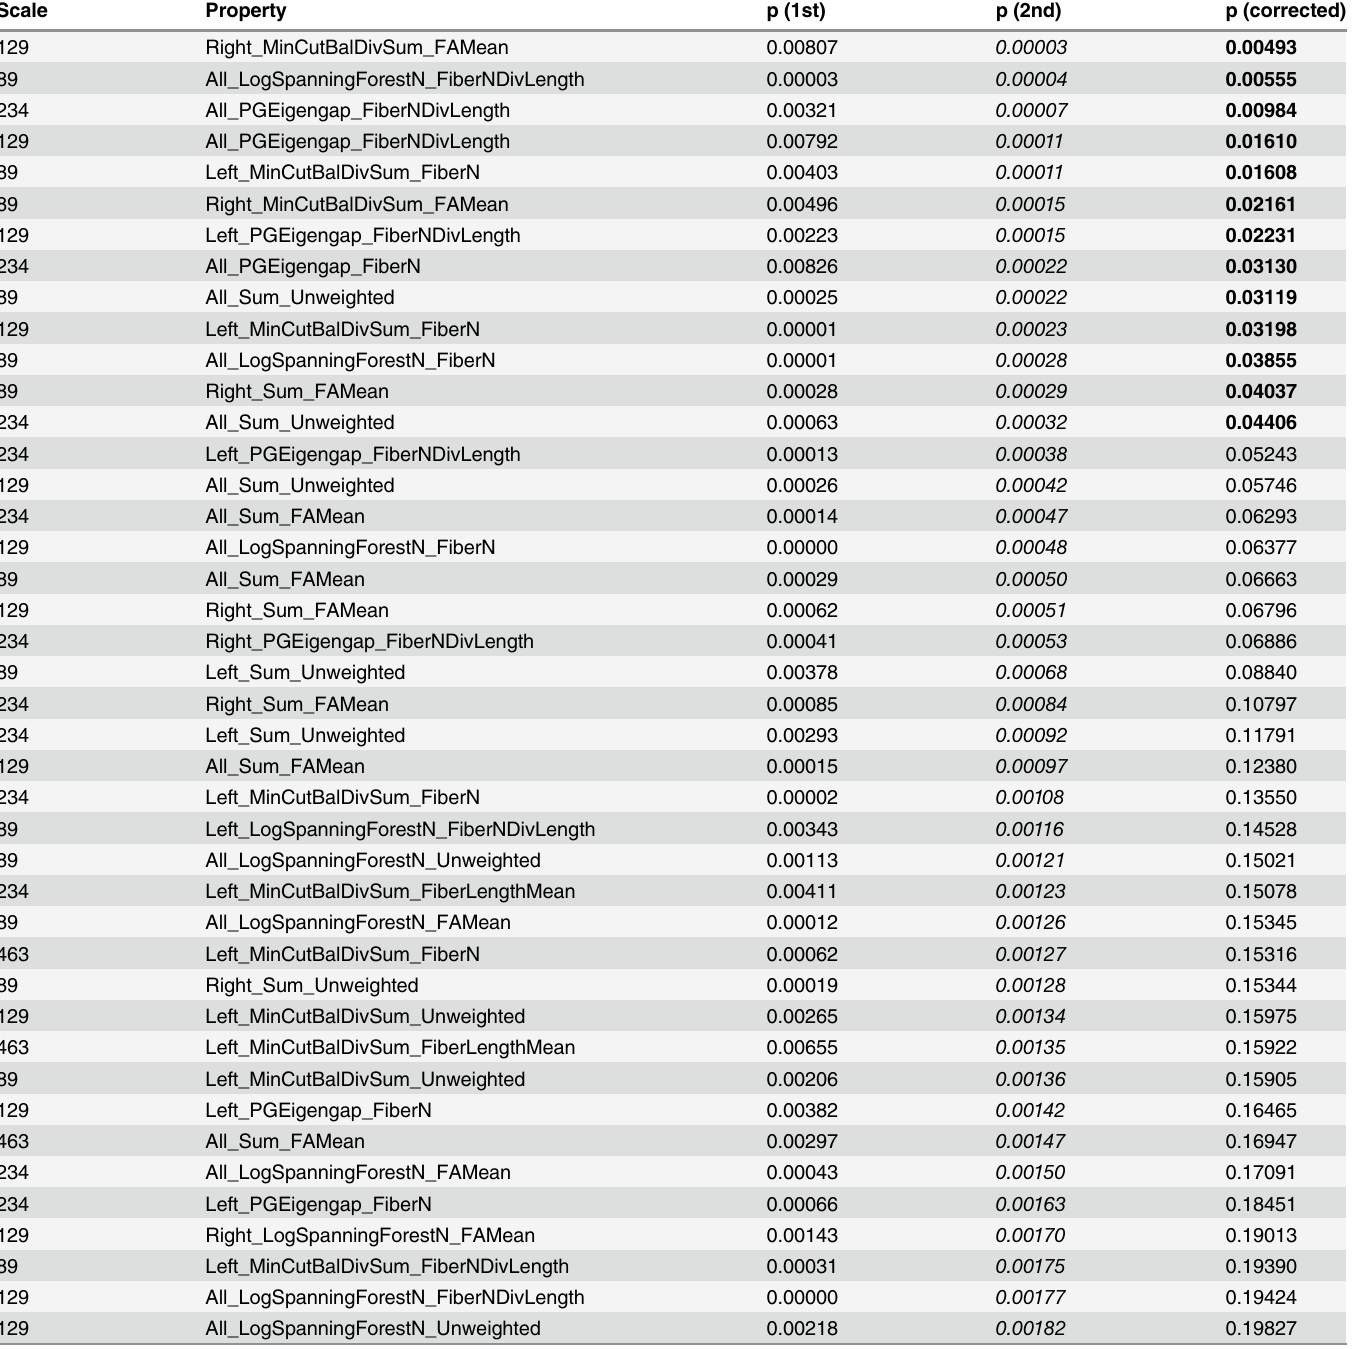
Table 1. The results and the statistical analysis of the graph-theoretical evaluation of the sex differences in the 96 diffusion MRI images. The first column gives the resolutions in each hemisphere; the numbers of nodes in the whole graph are 83, 129, 234, 463 and 1015. The second column describes the graph parameter computed: its syntactics is as follows: each parameter-name contains two separating “ _ ” symbols that define three parts of the parame- ter-name. The first part describe the hemisphere or the whole connectome with the words Left, Right or All. The second part describes the parameter com- puted, and the third part the weight function used (their definitions are given in section “ Materials and methods ” ). The third column contains the p-values of the first round, the second column the p-values of the second round, and the third column the (very strict) Holm-Bonferroni correction of the p-value. With p = 0.05 all the first 12 rows describe significantly different graph theoretical properties between sexes. One-by-one, each row with italic third column describe significant differences between sexes, with p = 0.05. For the details we refer to the section “ Statistical analysis ”